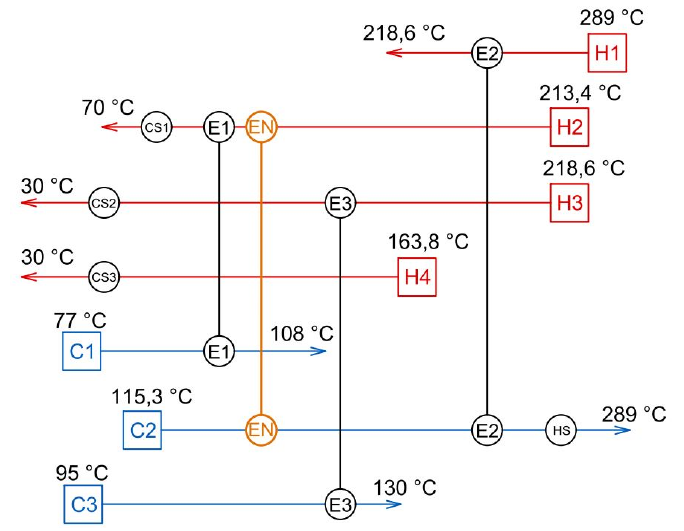
Figure 7. Modified Grid Diagram (GD) of the studied process.